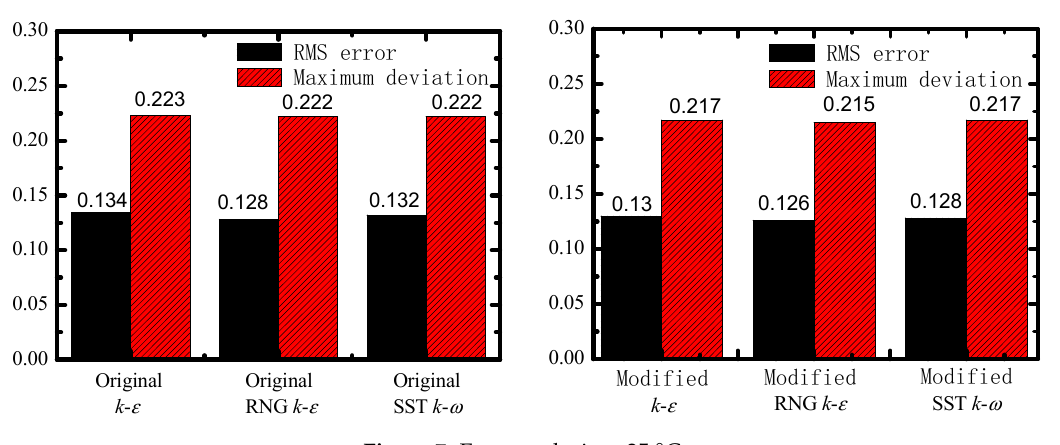
Figure 7. Error analysis at 25 ◦ C.